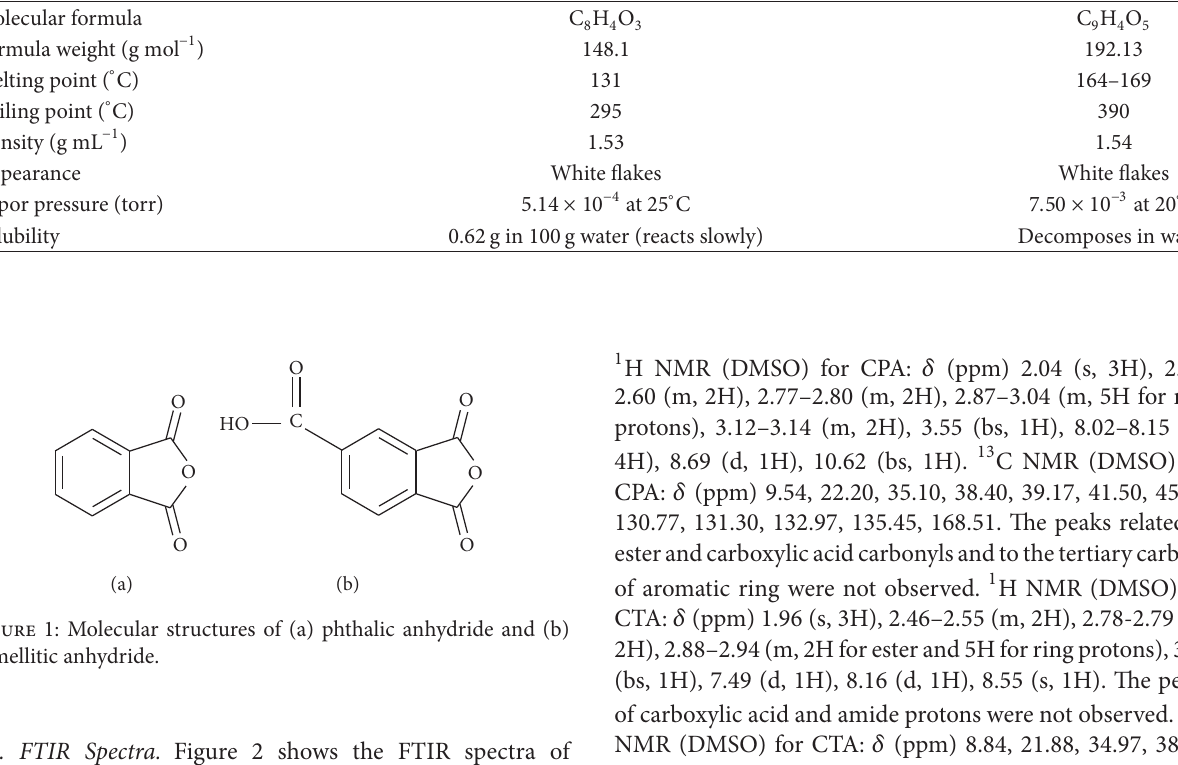
Broad singlet at 3.55 ppm with 1H intensity related to the secondary hydroxyl groups of CPA and broad singlet at 3.53 ppm with 1H intensity related to the secondary H NMR spectra show that hydroxyl groups of CTA in their esteri�cation reaction occurred with only or usually primary 1 hydroxyl groups. e primary hydroxyl groups according to the secondary hydroxyl groups in chitin react easier to form an ester because the nucleophilic attack of the secondary hydroxyl groups gets difficult due to the steric hindrance of chitin ring. Scheme 1 in [30� is con�rming this